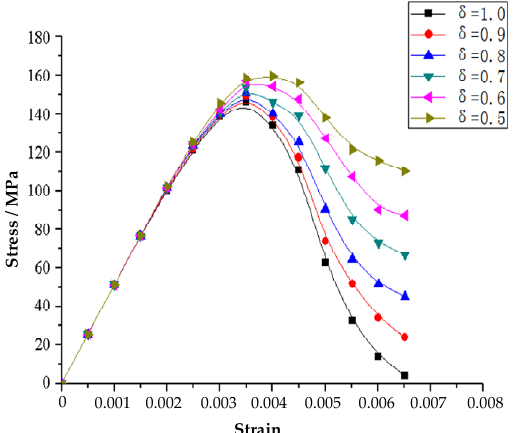
Figure 4. Relationship between damage modification coefficient and stress ‐ strain curve.